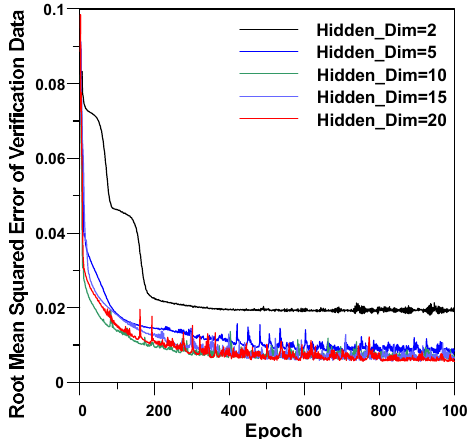
Figure 7. RMSE variation versus epoch of RNN model for Example 1.